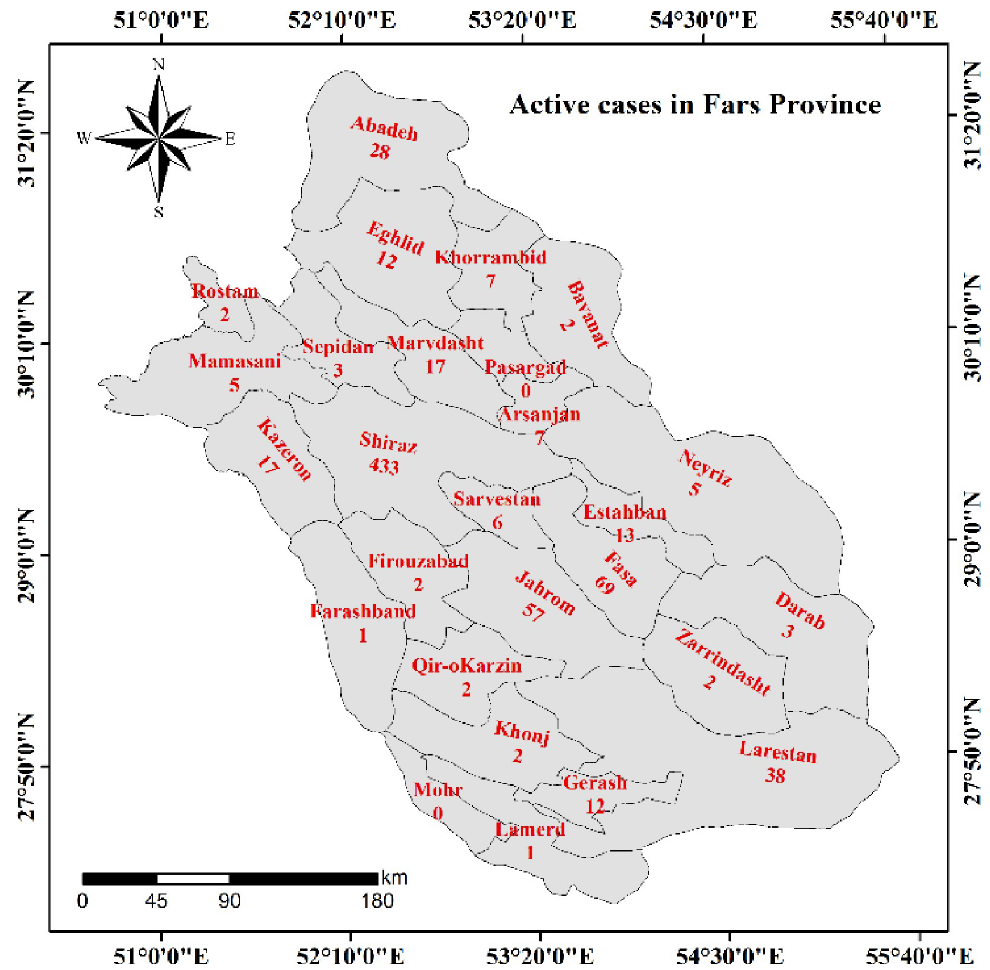
Fig 1. The counties of Fars Province, Iran, and the number of COVID-19 infected case identified from March 29, 2020.